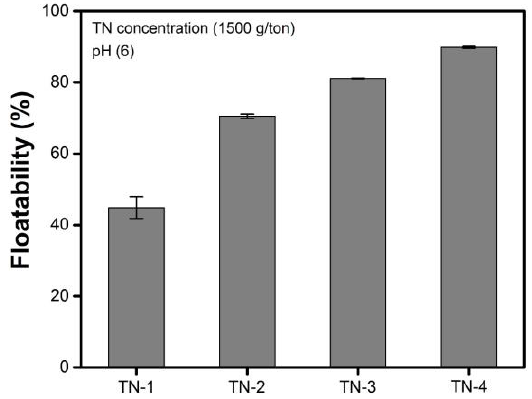
Figure 5. Malachite floatability as a function of the median diameter of TNs. The flotation tests were performed with 1500 g / ton TN concentration at pH 6. Table 1. The amounts of TNs deposited on the surface of malachite using TN-1, TN-2, TN-3, and TN-4, respectively. The absorbance tests were carried out with 1500 g / ton TN concentration at pH 6.